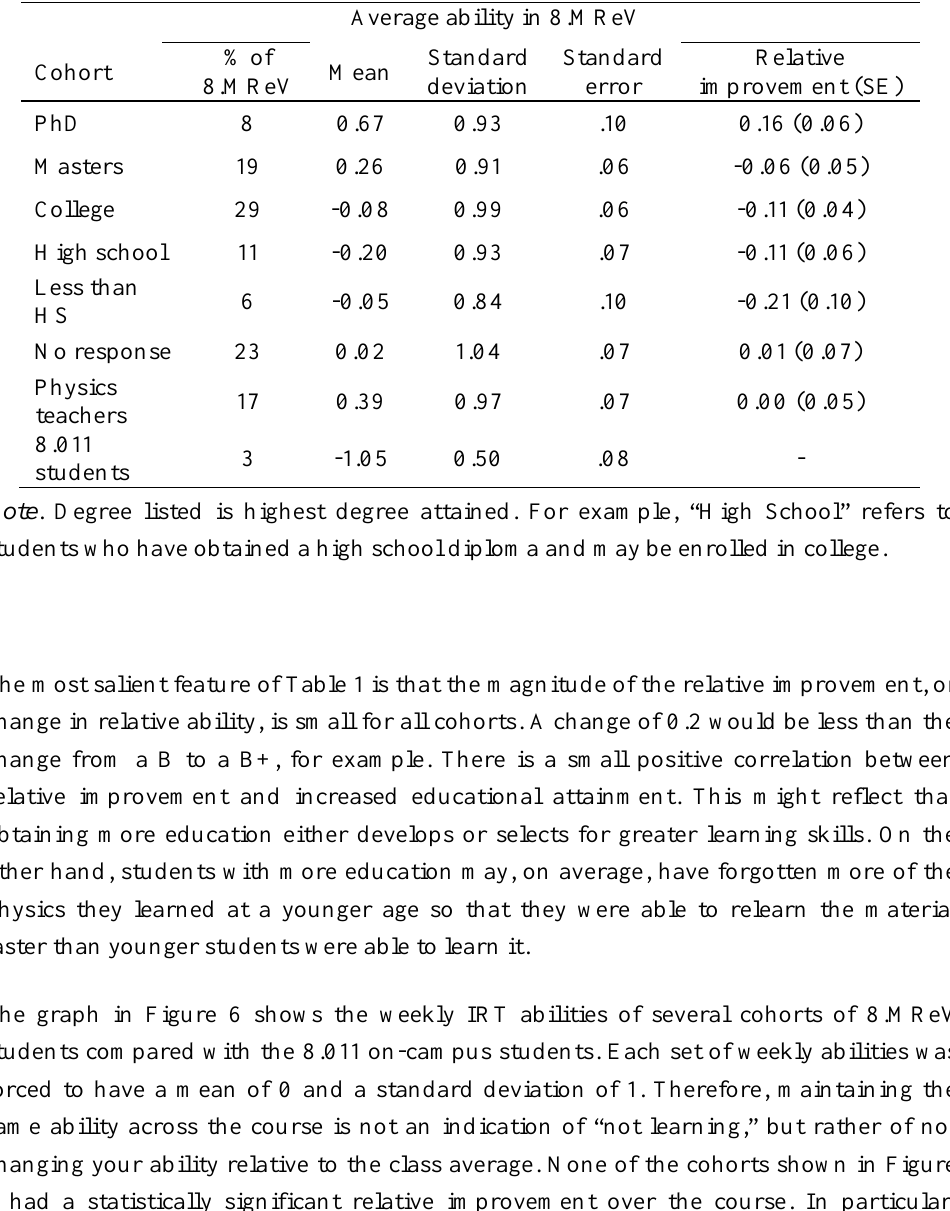
Table 1 Average Ability of Various Cohorts